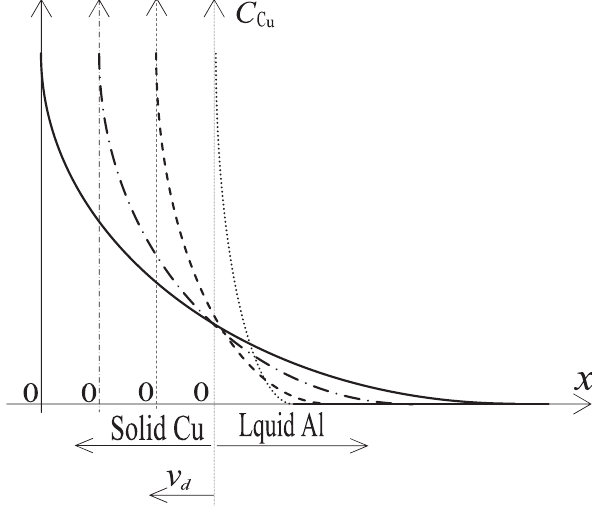
Figure 7: Schematic diagram of the concentration distribution of Cu in the molten aluminum after the Cu dissolution v d -the dissolution rate of Cu; x - the